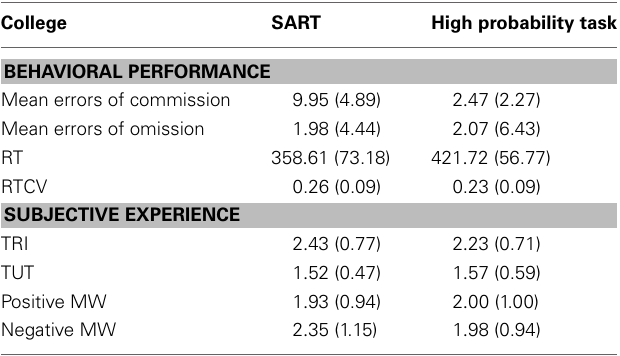
Table 3 | Behavioral performance and subjective experience data for all participants in the SART and high probability